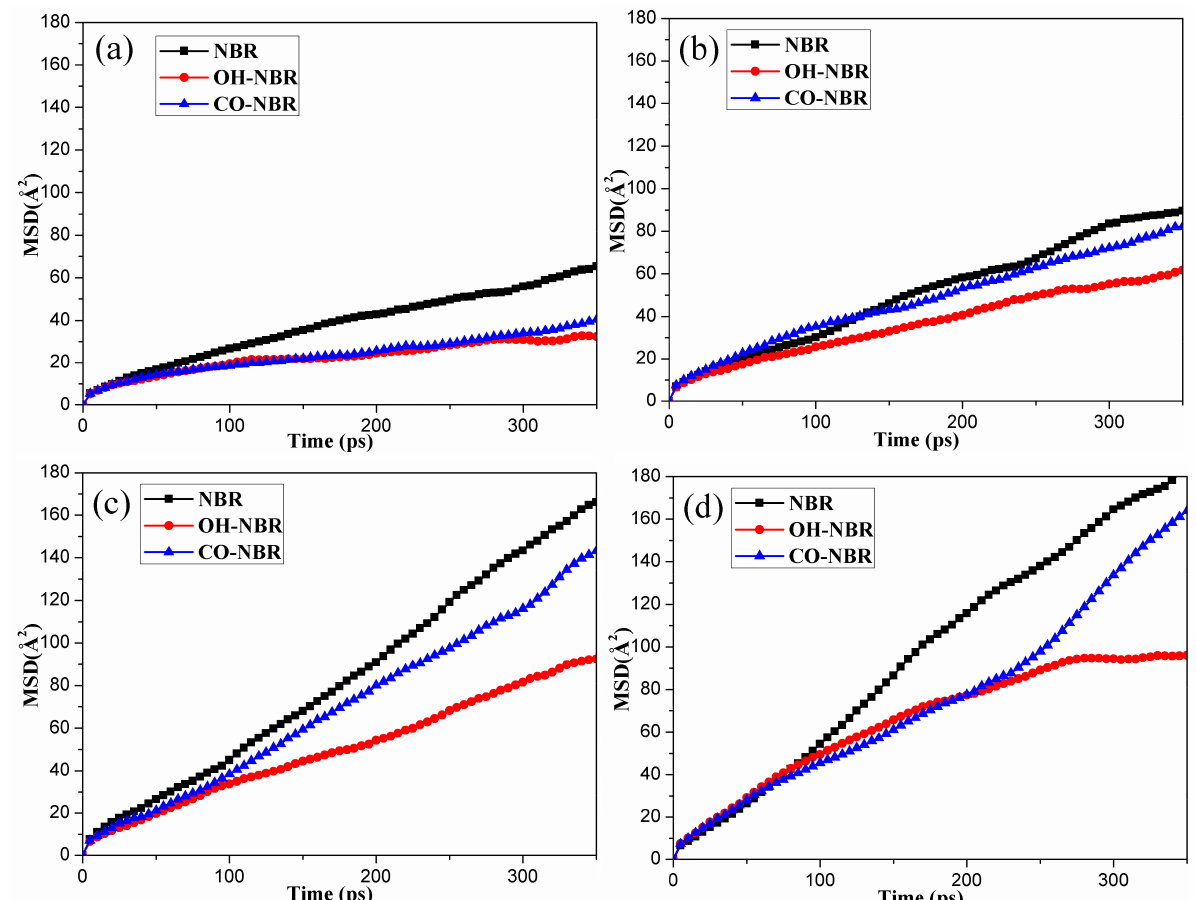
Figure 6. The MSD of the oxygen molecules with simulation time in the unaged and aged NBR models: ( a ) 298.15 K; ( b ) 343.15 K; ( c ) 363.15 K; ( d ) 383.15